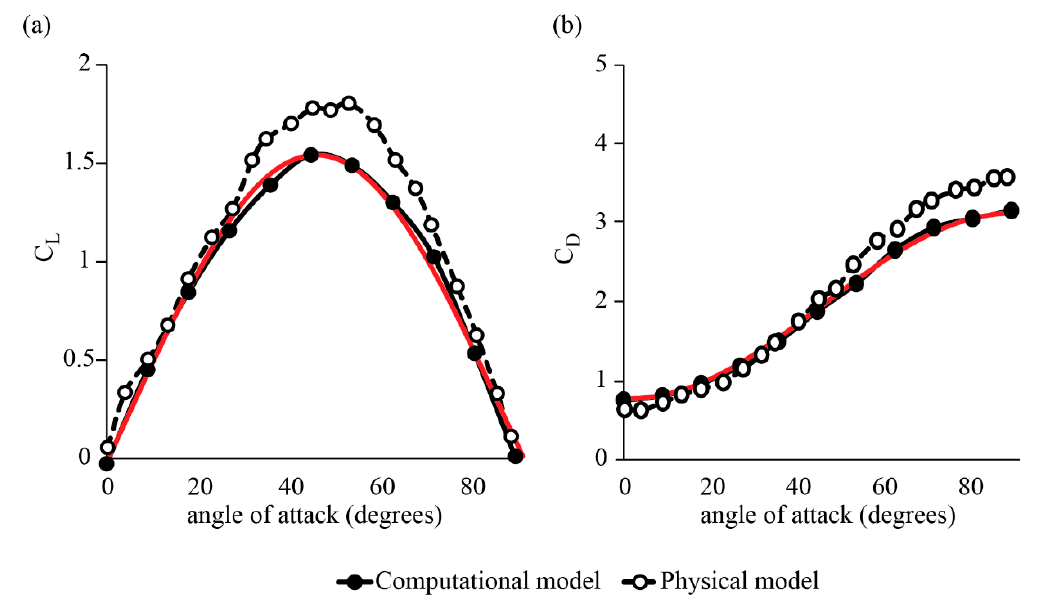
Figure 3. The comparison of ( a ) lift and ( b ) drag for the computational (solid markers) and experimental (open markers) models over a range of angles of attack at Re = 130. The red lines show the quasi-steady force model described in Dickinson et al. [40].